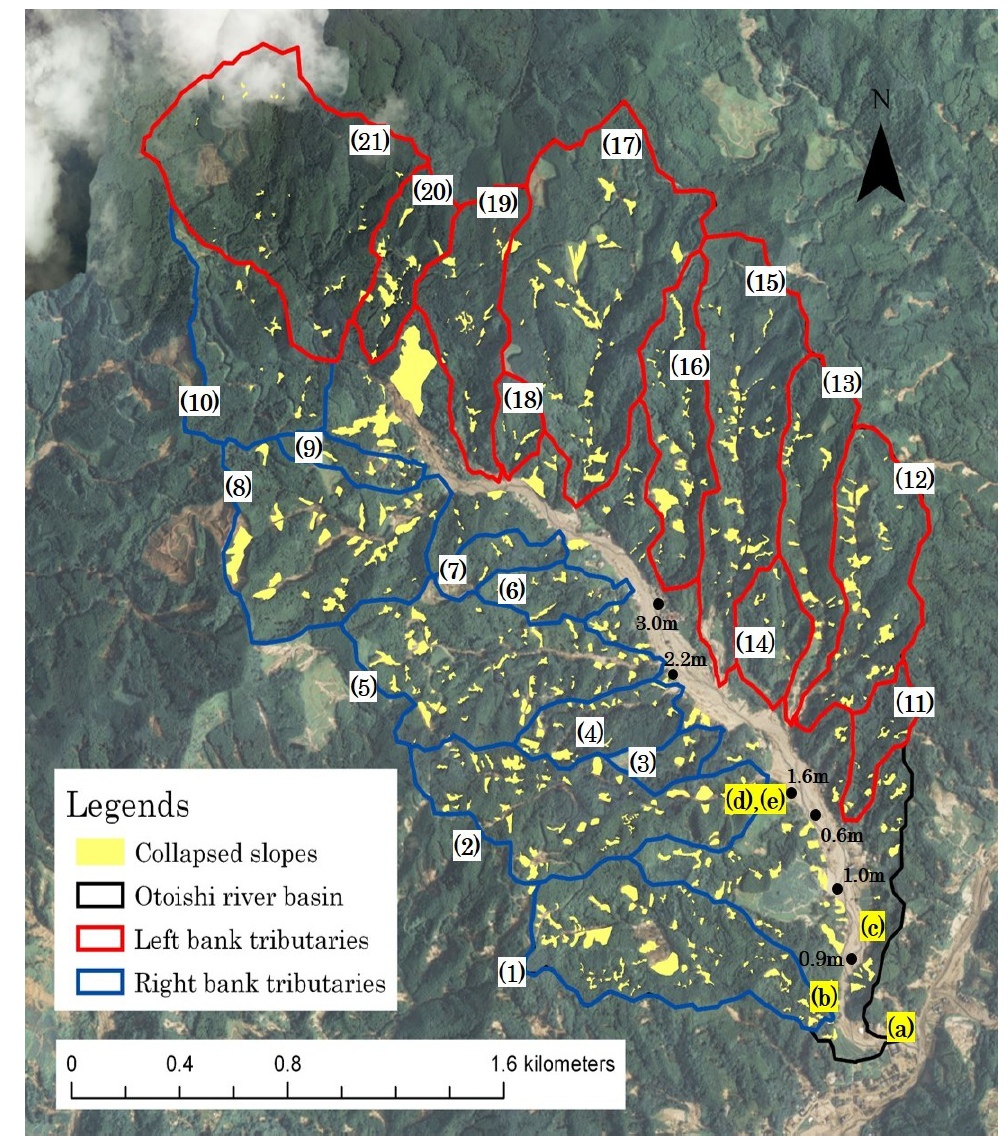
Figure 3. The distribution of collapsed slopes mapped from aerial photographs in the Otoishi River (the photo sites and the sediment thickness are described in this figure).